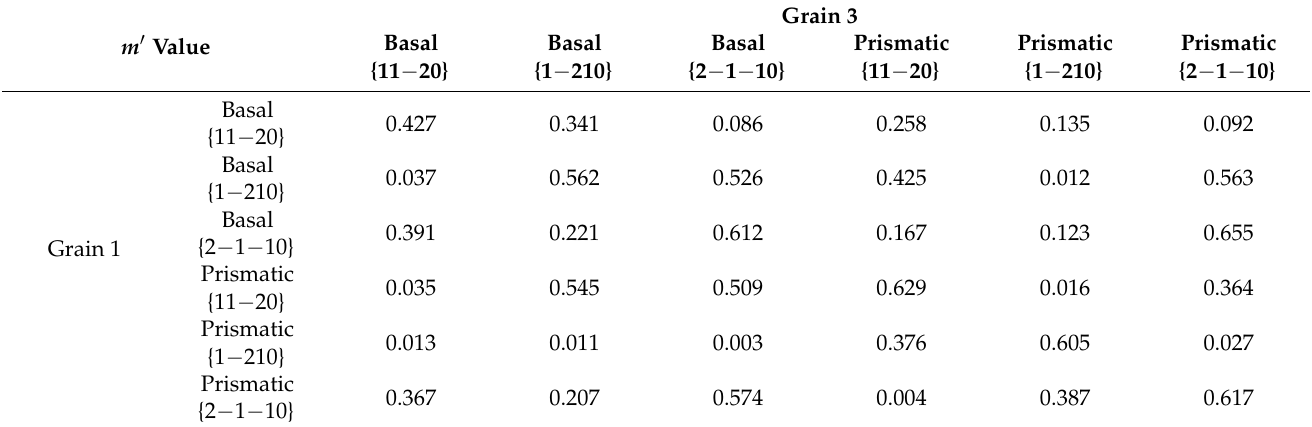
Table 2. m (cid:48) value between different slip systems from Grain 1 and Grain